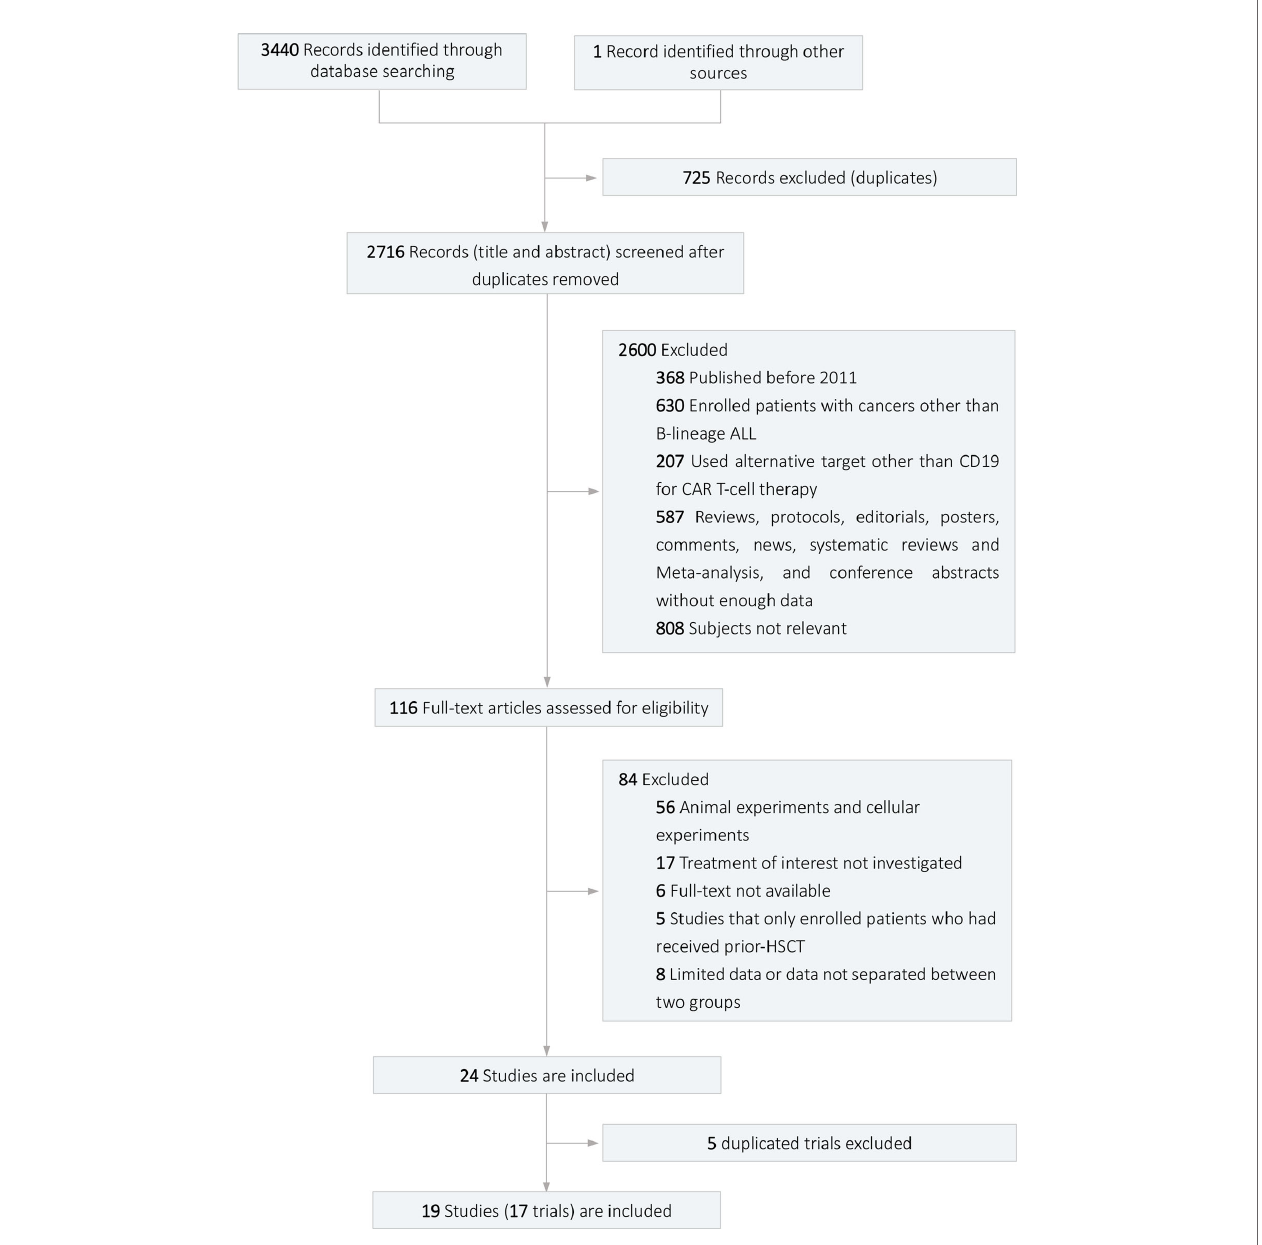
FIGURE 1 | Flow diagram of the study selection